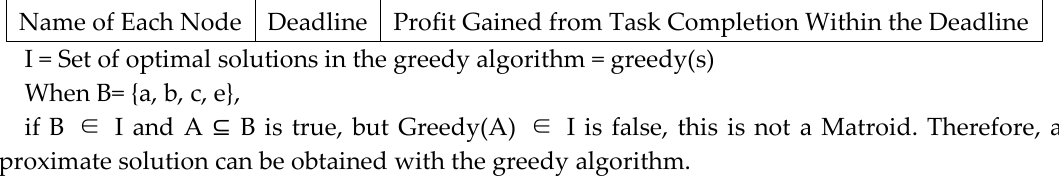
Table 1. Organization of Zigbee Nodes and Mechanism.